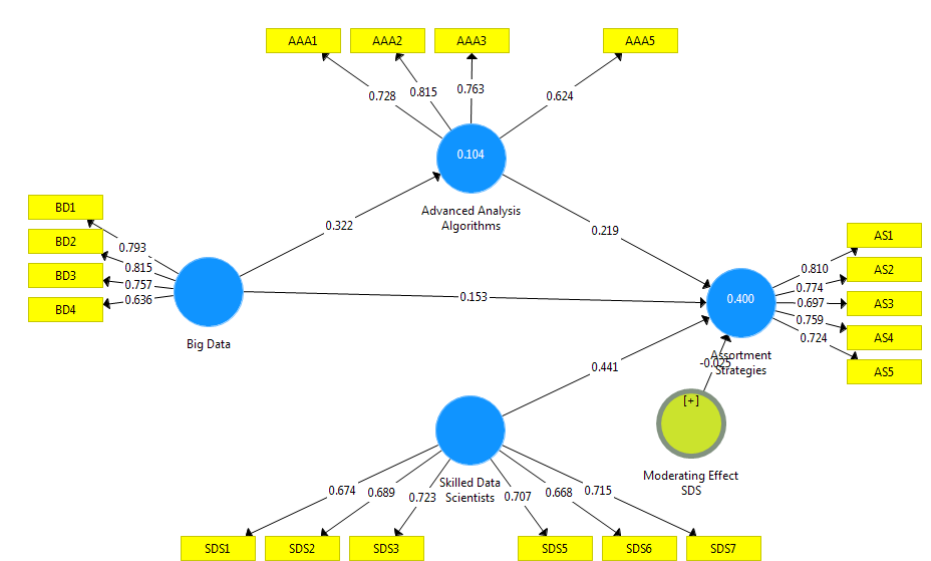
Figure 2: Confirmatory Factor